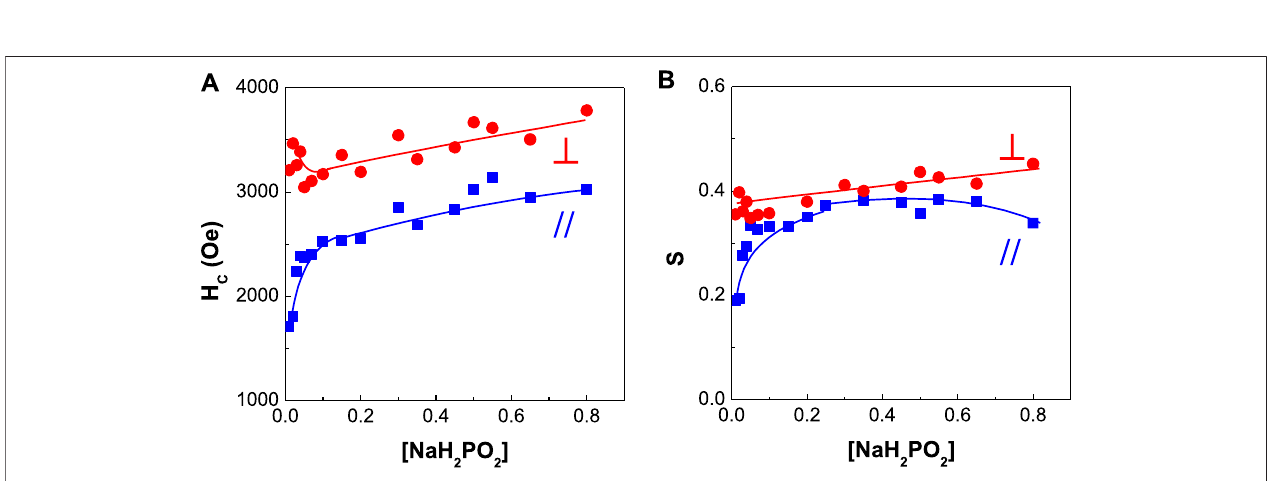
Frontiers in Chemistry |